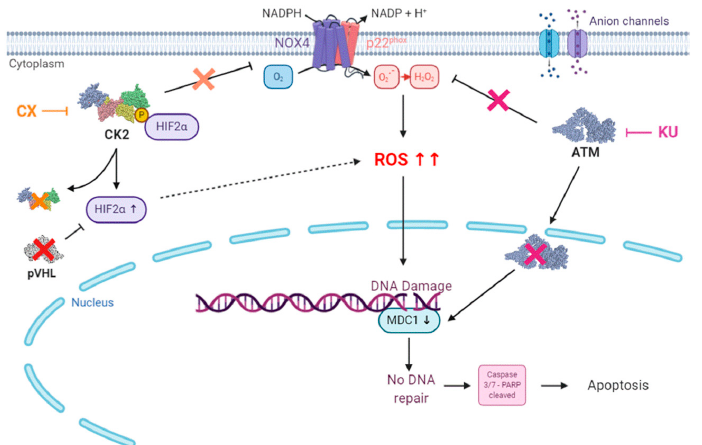
Figure 6. Proposed mechanistic model for the combinational drug therapy targeting CK2 and ATM: In renal cells, the NADPH oxidase 4 (NOX4) enzyme is responsible for ROS production. NOX4 activity is downregulated by CK2-dependent phosphorylation. Inhibition of CK2 by the CX-4945 inhibitor releases the CK2-dependent NOX4 inhibition, leading to ROS generation and HIF-2 α induction. ATM inhibition by KU-60019 also induces ROS generation. ROS induced DNA damages and ion channels expression alteration. Both ATM and CK2 are involved in DNA repair machinery. Therefore, their inhibition prevents ROS-induced DNA damages repair, leading to apoptotic cell death. Loss of functional VHL leads to HIF-2 α accumulation. HIF-2 α appears as a biomarker of which expression level is correlated with sensitivity to this combined CK2/ATM inhibition (Direct link, full line; indirect link, dashed line).